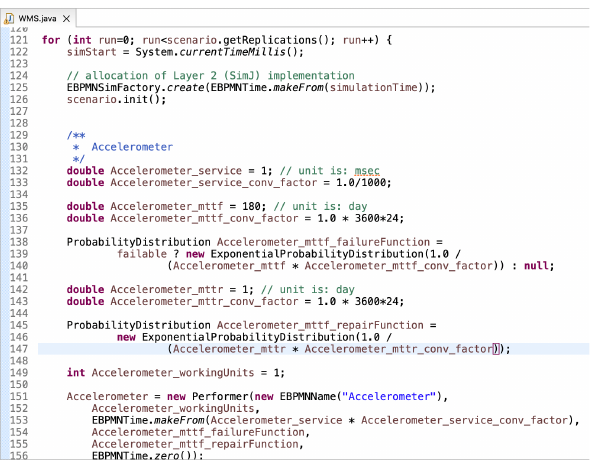
Figure 17. Fragment of the IoT-ware BP Digital Twin implemented in eBPMN-based Java code.